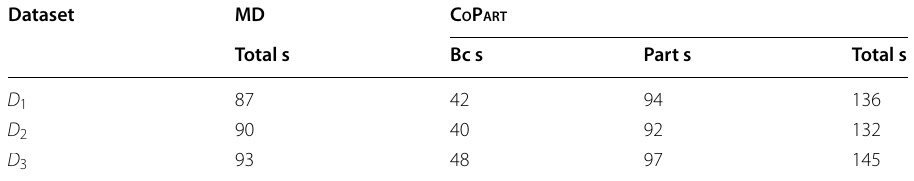
Table 5 Time required for performing the partitioning of the three datasets with MD and C o P art